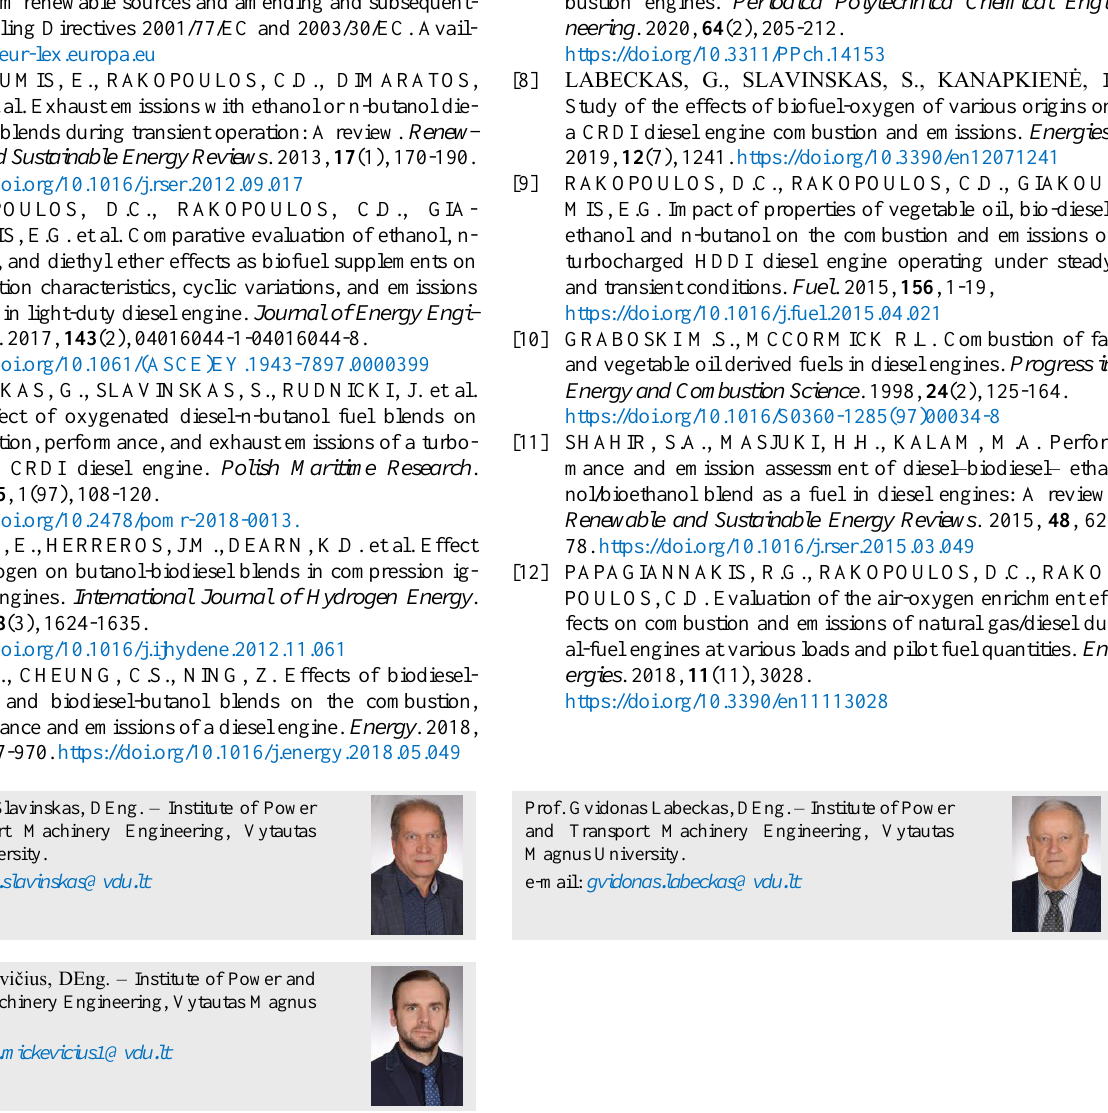
table oil blends as a diesel extender option for internal